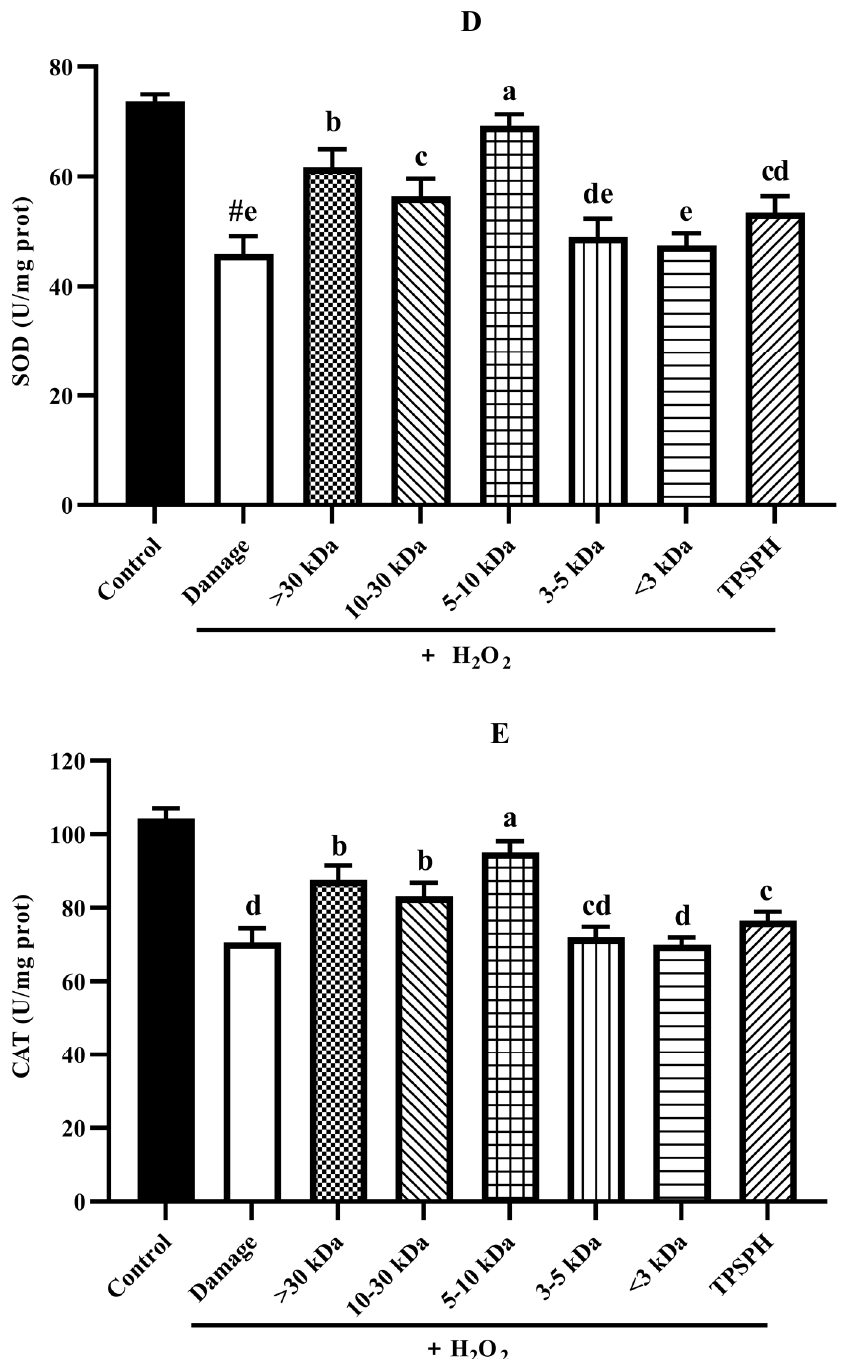
Figure 7. The potential antioxidant mechanisms of TPSPH and five fractions on cell damage induced by H 2 O 2 . ( A ) ROS levels in HepG2 cells (fluorescence intensity of DCF was measured at an excitation wavelength of 485 nm and an emission wavelength of 525 nm). ( B ) MDA levels in HepG2 cells. ( C ) LDH levels in HepG2 cells. ( D ) SOD activity in HepG2 cells. ( E ) CAT activity in HepG2 cells. # p < 0.05 versus the control group, different letters indicate significant differences between sample groups and the damage groups.